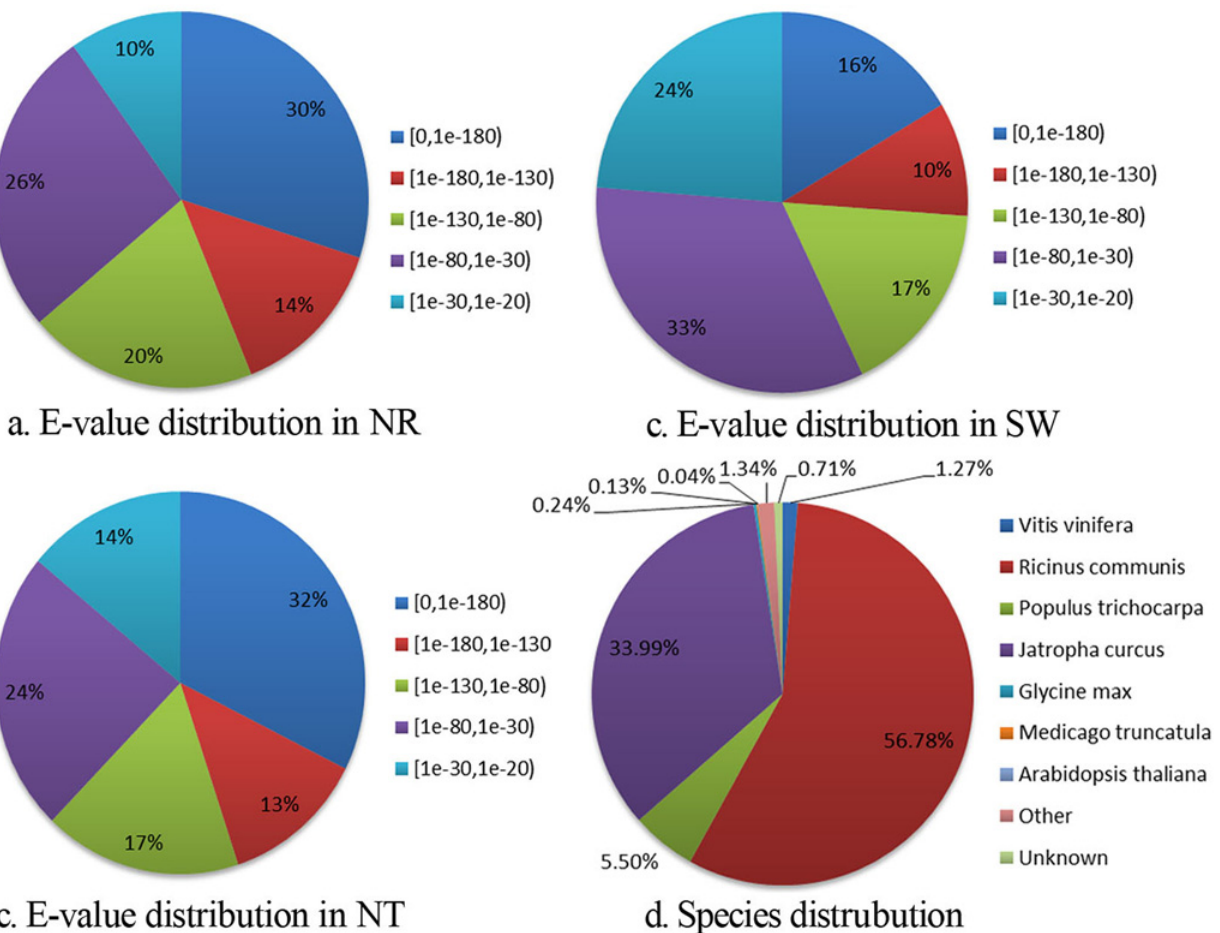
Fig 3. Characterization of searching the assembled unigenes against NR, NT and Swiss-Prot protein databases. a. E-value distribution of BLAST hits for the assembled unigenes in NR database; b.E-value distribution of BLAST hits for the assembled unigenes in NT; c. E-value distribution of BLAST hits for the assembled unigenes in Swiss-Prot database. d. Species distribution of top hits in NT